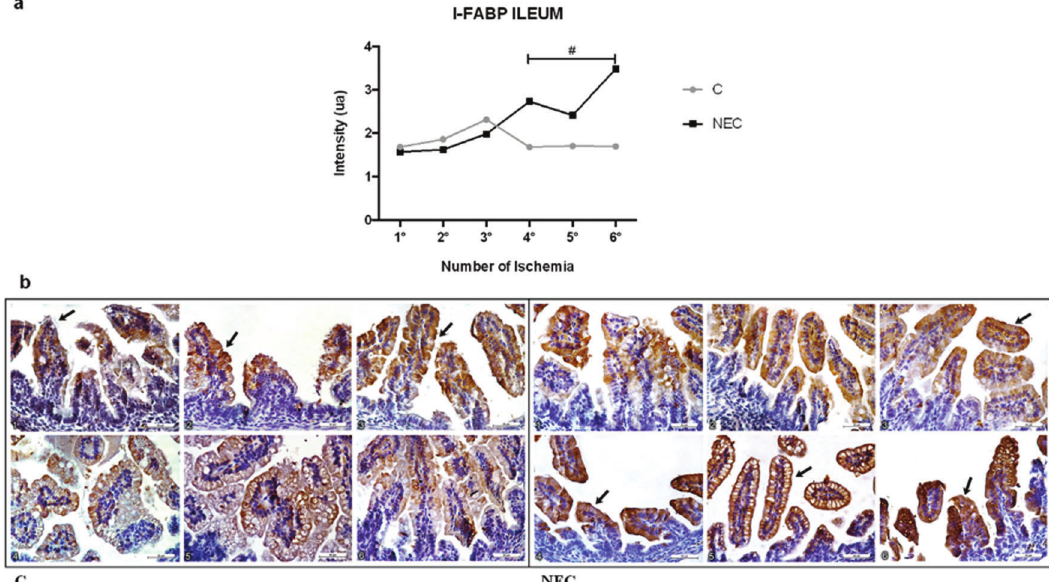
Figure 4 - Graphs of I-FABP expression in the ileum. a) The means and standard deviation of the arbitrary scores of I-FABP immunolabeling intensity (au) in the ileum over three days were compared between the two groups. b) Immunohistochemistry for I-FABP in the ileum relative to the C group. I-FABP immunolabeling intensity increased from the first to the sixth experimental time point (scale bar=50 m m). # p o 0.0005.